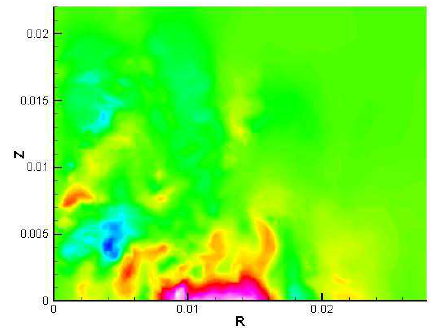
Figure 2: Toroidal magnetic field distribution at the moment of its maximal energy for the initial quadrupole field